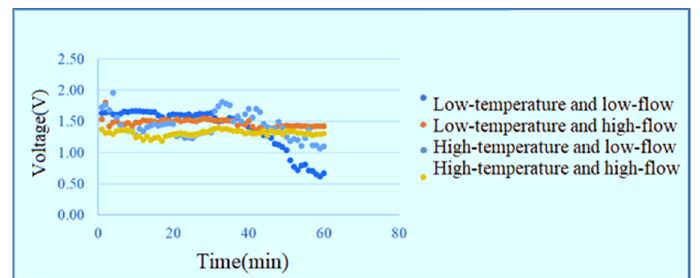
Figure 10. Voltage data at lower inlet of runner.